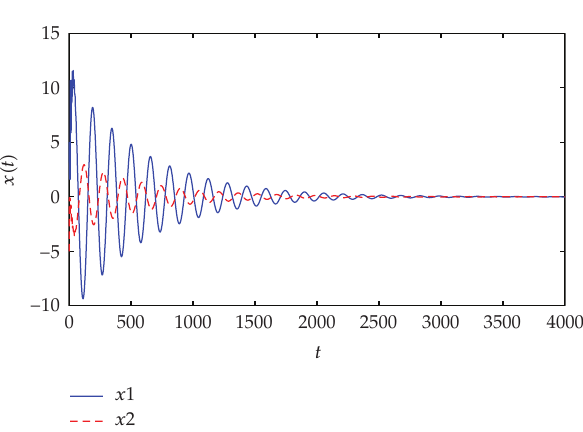
Figure 1: State trajectories of system (cid:2) 12 (cid:3) with cc (cid:9) 0 . 4 , h (cid:9) τ 1 (cid:9) τ 2 (cid:9) 1 . 60 , E a (cid:9) E b (cid:9) E d (cid:9) 0 . 2 I,K (cid:9) I.